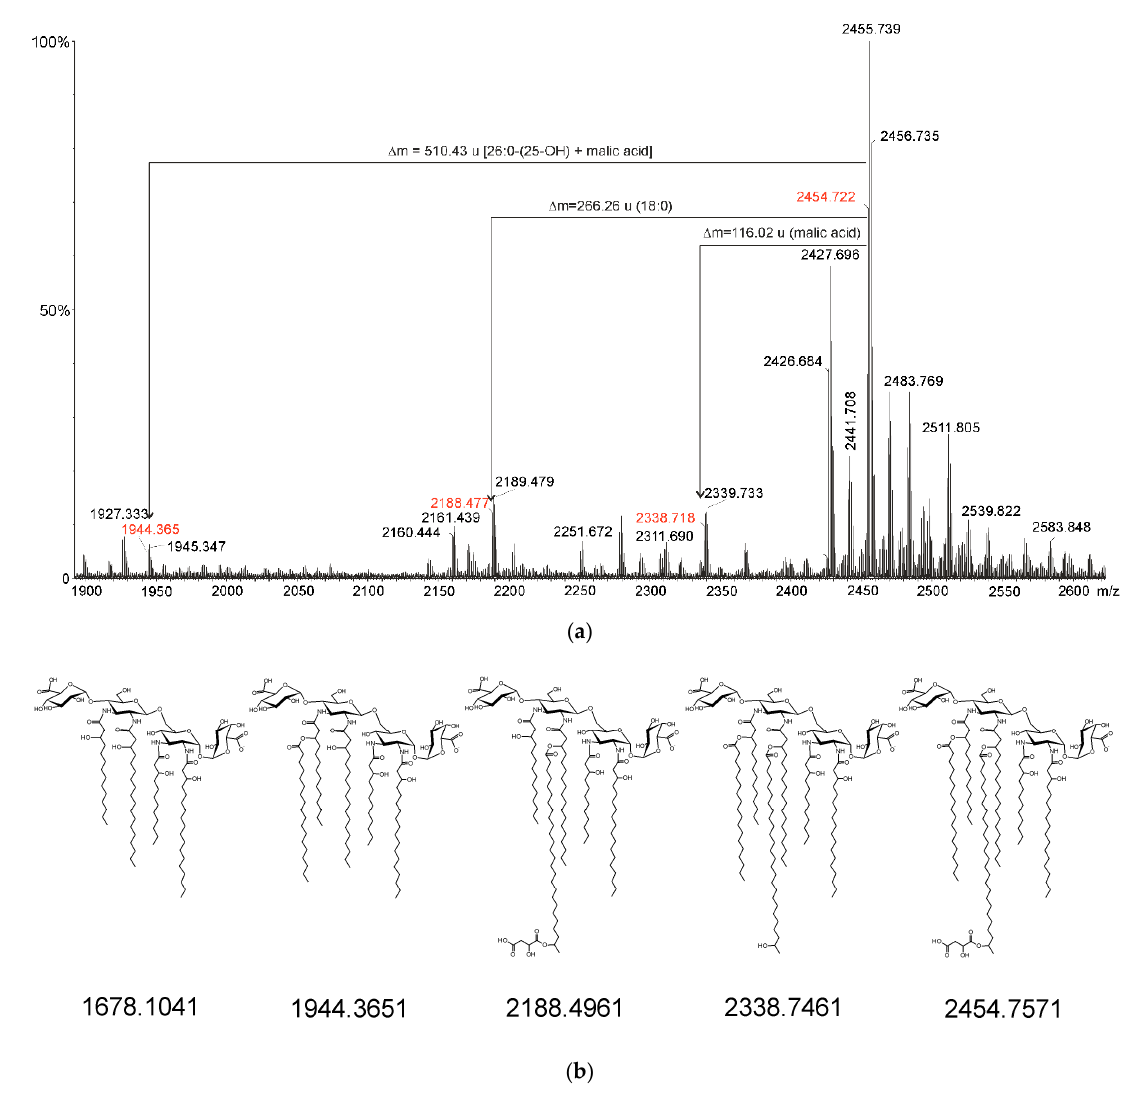
Figure 3. Negative mode MALDI-TOF mass spectrum of native lipid A from O. carboxidovorans OM5 ( a ); proposed formulas of lipid A ions presented in the lipid A mass spectrum (with calculated m/z values) ( b ). The m/z values marked in red at part ( a ) refer to the relevant chemical formulas given in part ( b ) of the figure.